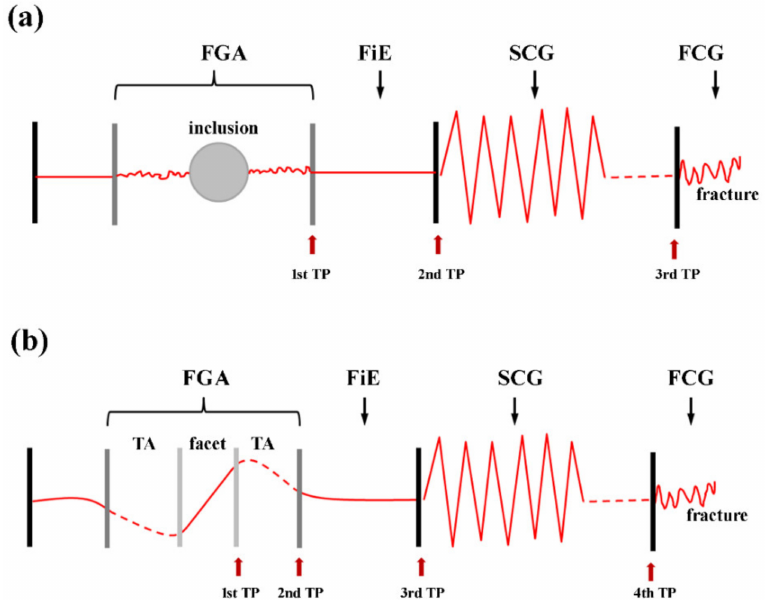
Figure 5. Schematic showing whole fatigue process from crack initiation to final fracture for ( a ) inclusion-induced crack initiation and ( b ) “noninclusion-induced crack initiation”; TA: tran- sition area, FiE: fish-eye, FGA: fine granular area, SCG: steady crack growth, FCG: fast crack growth, TP: transition point. Reprinted with permission from Refs. [29,30]. 2022, Elsevier. In the geometric parameter models proposed by Murakami et al. [15], the size of √ area ”, which is the crack initiation site (i.e., inclusion or defect) is denoted by the term “ projected area of the inclusion or the defect on to the plane perpendicular to the